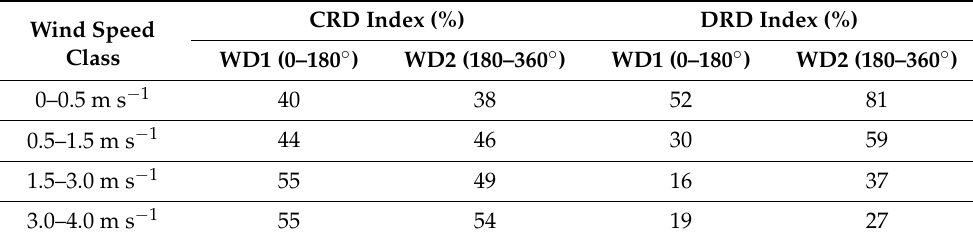
Table 4. CRD and DRD index value, expressed in percentage, for two different wind direction classes, WD1 and WD2 (0–180 ◦ and 180–360 ◦ , respectively) in a high-turbulence scenario. The results are presented for the first four wind speed